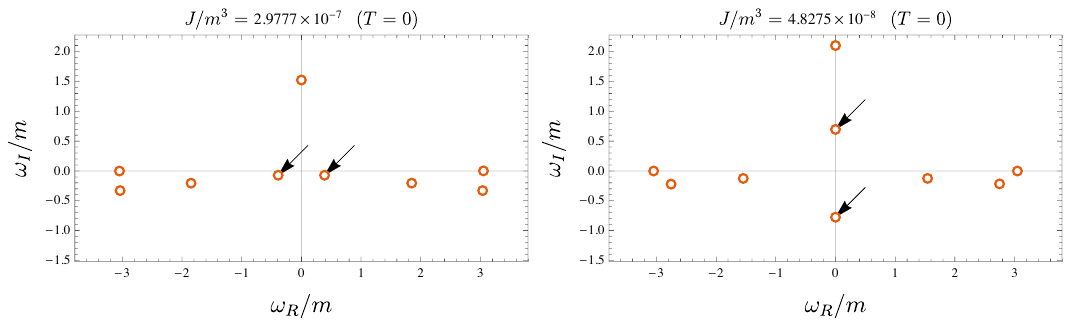
Figure 10 . Frequencies of the QNMs on the complex plane of ω = ω R + iω I around the second turning point of E – J curve. In each panel the two poles pointed by the arrows involve the second turning point.